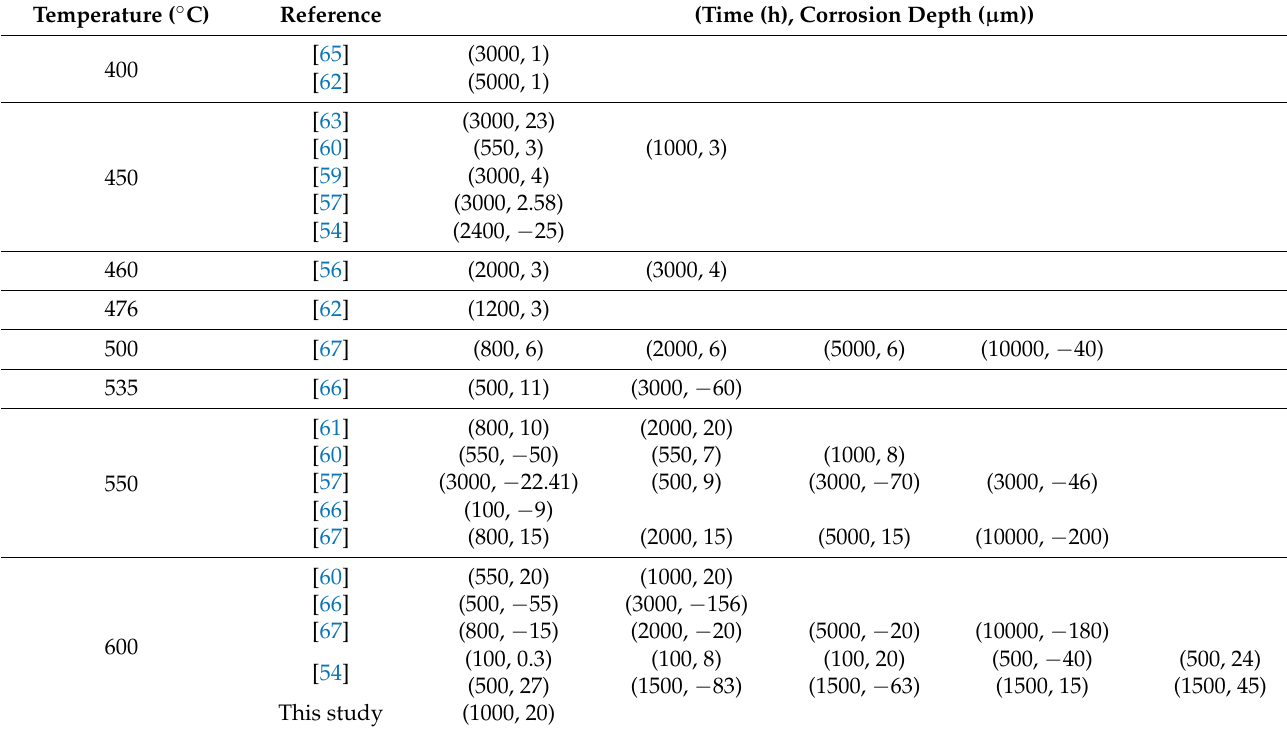
Table A3. Data points plotted in Figure 17 [54,56,57,59–63,65–67].